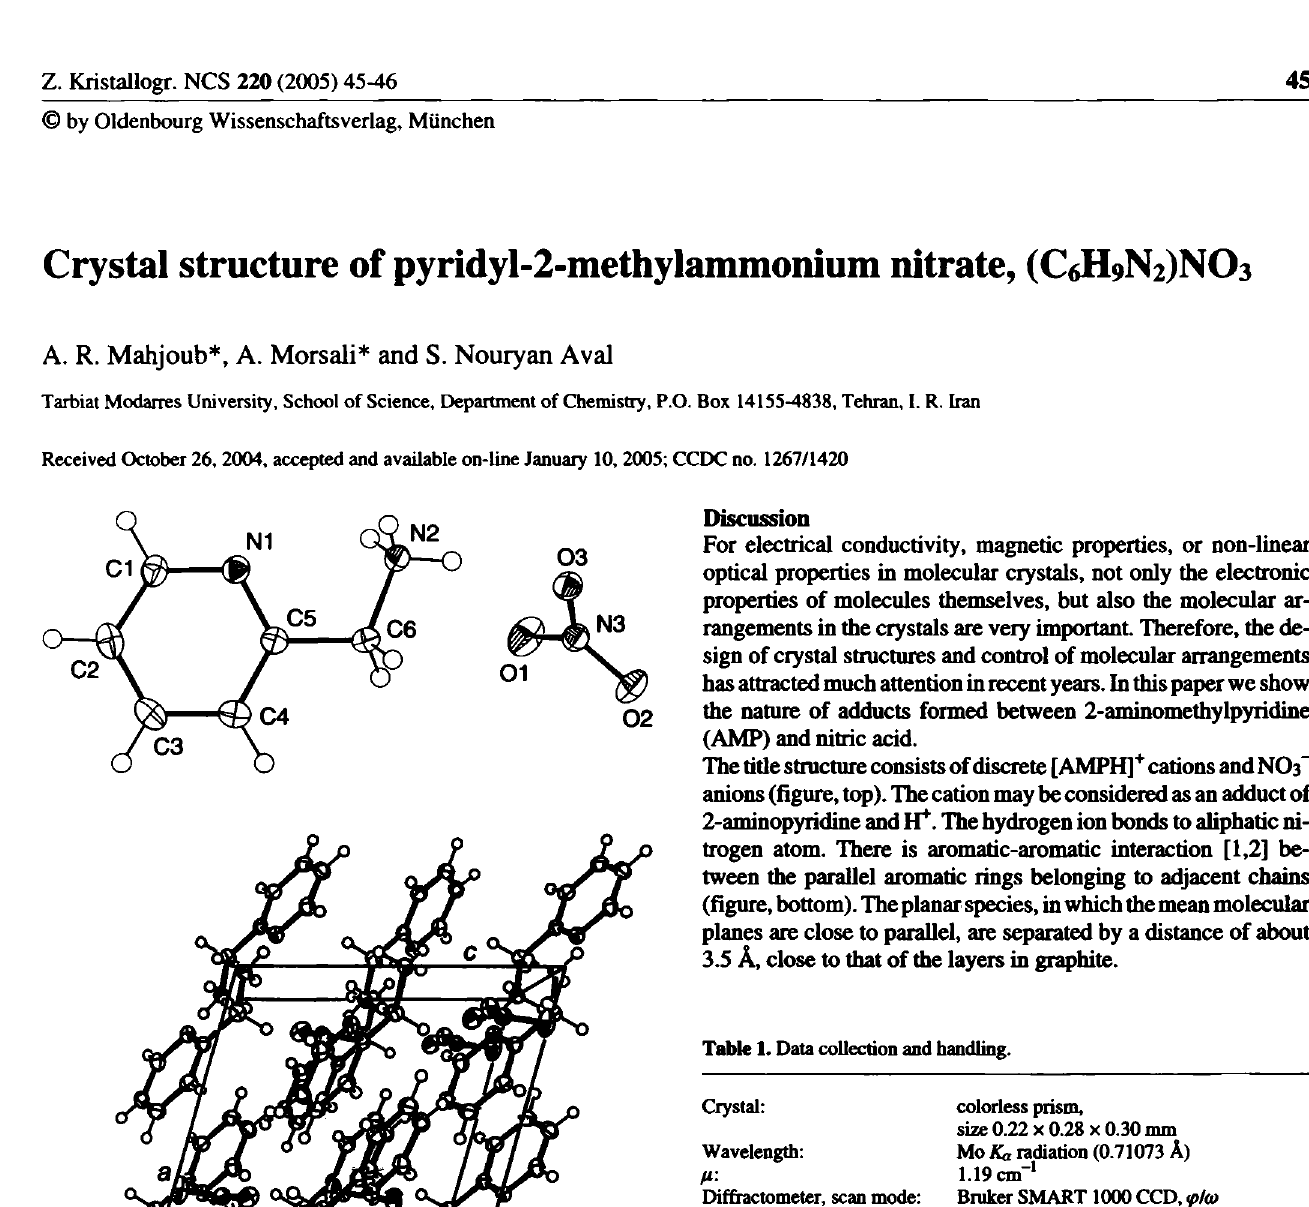
Table 2. Atomic coordinates and displacement parameters (in A 2